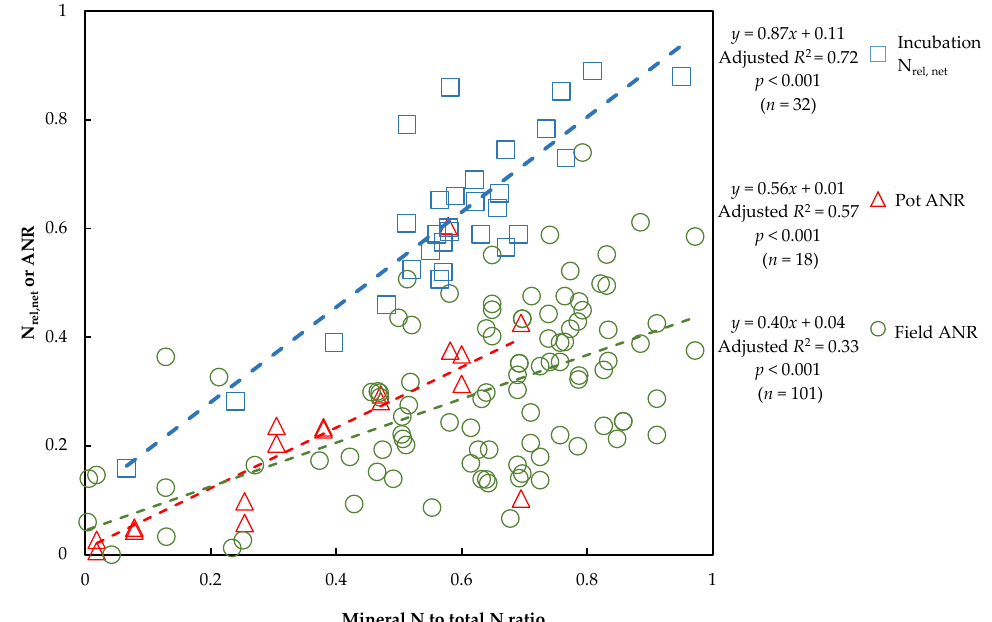
Figure 7. Regressions of the N rel, net determined by incubation method or ANR determined by plant experiments (field or pot) against the mineral N to total N ratio of biobased fertilizers. The dotted lines indicate their relationship estimated by linear regression. Data were collected from published studies and this study (see Table 3).